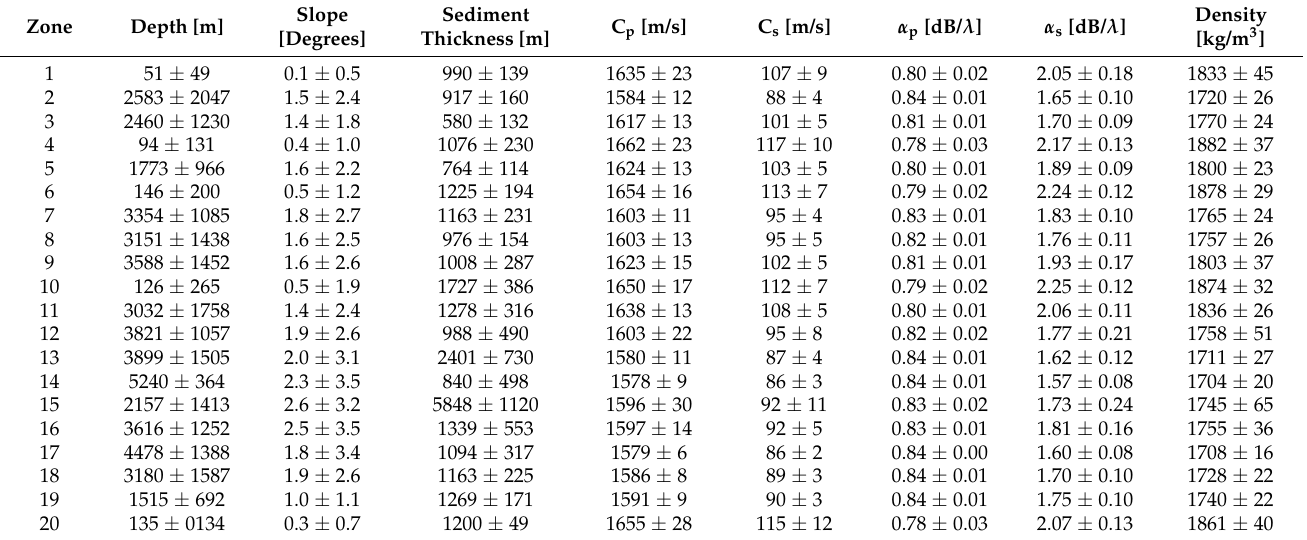
Table 3. Average ( ± SD) parameters of the 20 acoustic zones produced by the clustering model: Water depth, seafloor slope, sediment thickness, compressional (c p ) and shear (c s ) speeds, compressional ( α p ) and shear ( α s ) absorption coefficients, and density. λ is the acoustic